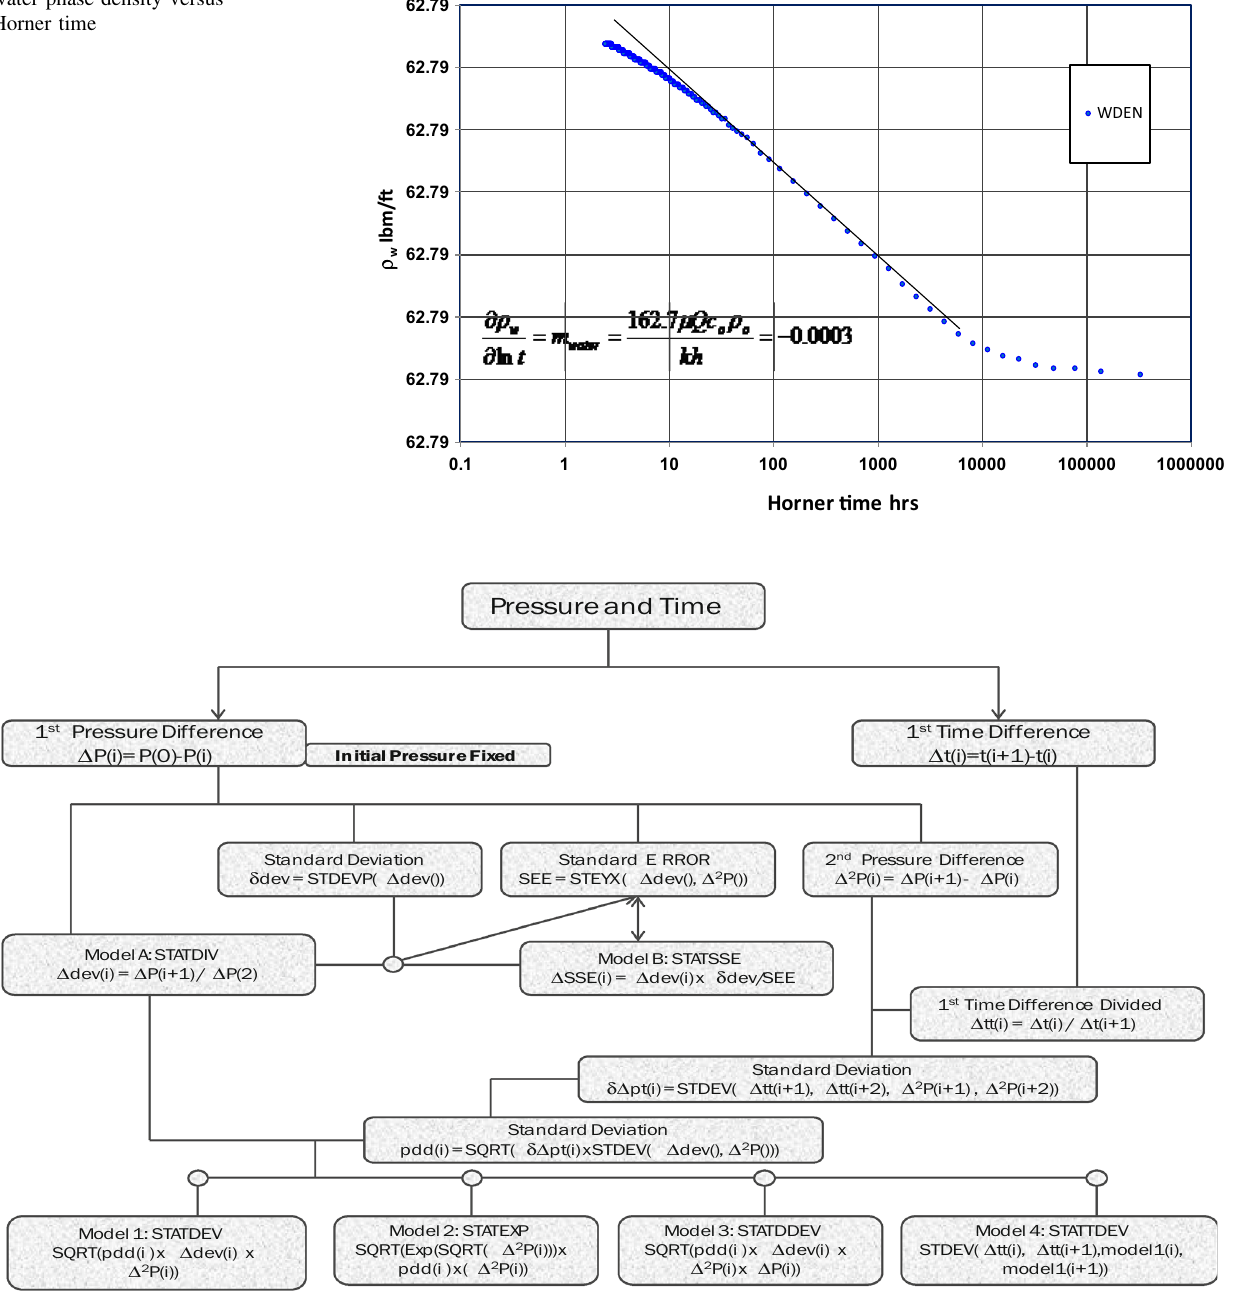
Fig. 17 Workflow for statistical models formulation using pressure